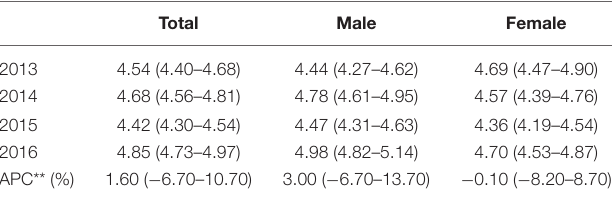
TABLE 6 | Annual age-standardized incidence rate of ulcerative colitis among urban employees in 23 provinces (municipalities, autonomous regions) of China from 2013 to 2016 (per 100,000 persons) * .